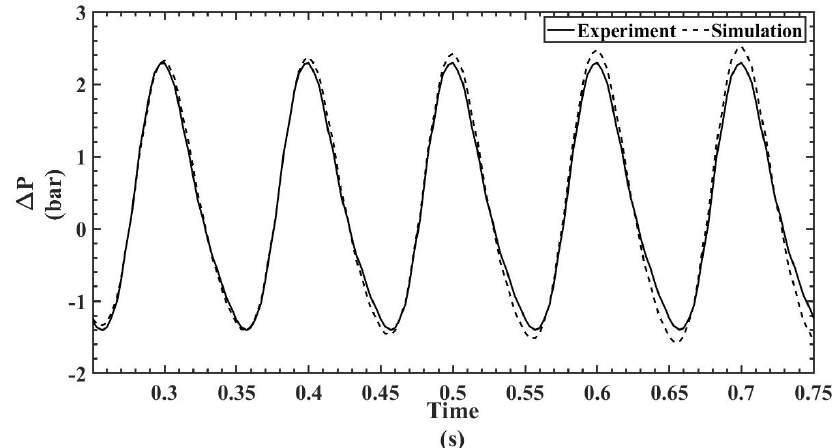
Figure 19. Temporal pressure drop for a 300 mesh regenerator at 600 RPM.